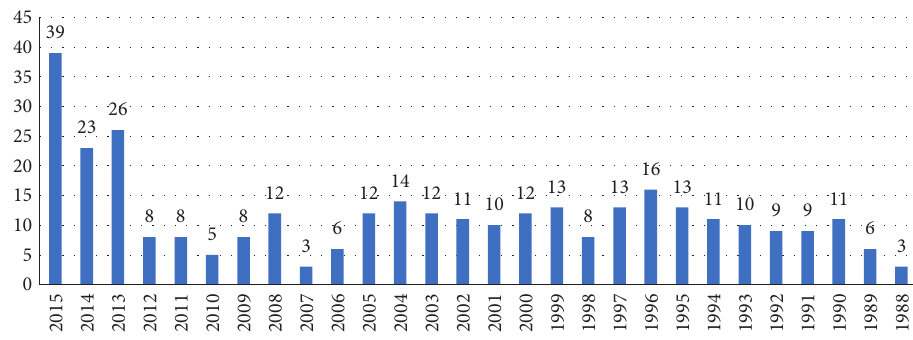
Figure 2: Data on HE yearbooks. Table 1: The entire experimental